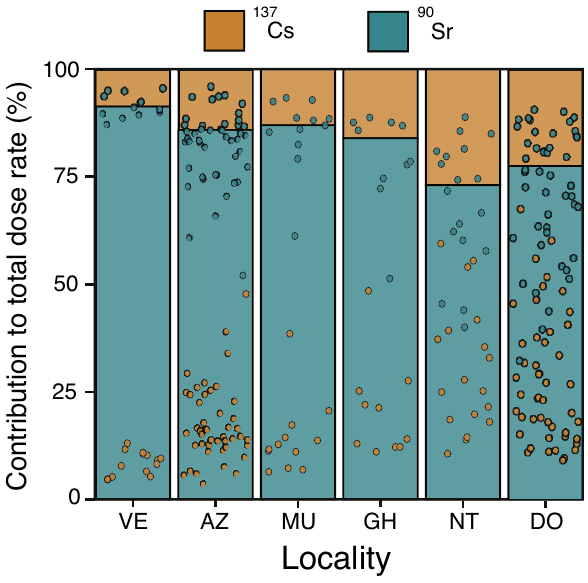
Figure 5. Contribution of 90 Sr and 137 CS (in percentage), to total dose rate absorbed by breeding Eastern tree frog ( Hyla orientalis ) males living in the Chernobyl Exclusion Zone (in individuals from localities with ambient dose rate > 1 μSv/h). Bars represent the locality average contribution for both isotopes, and points the contributions of each individual/isotope combination. See Fig. 1 for correspondence of